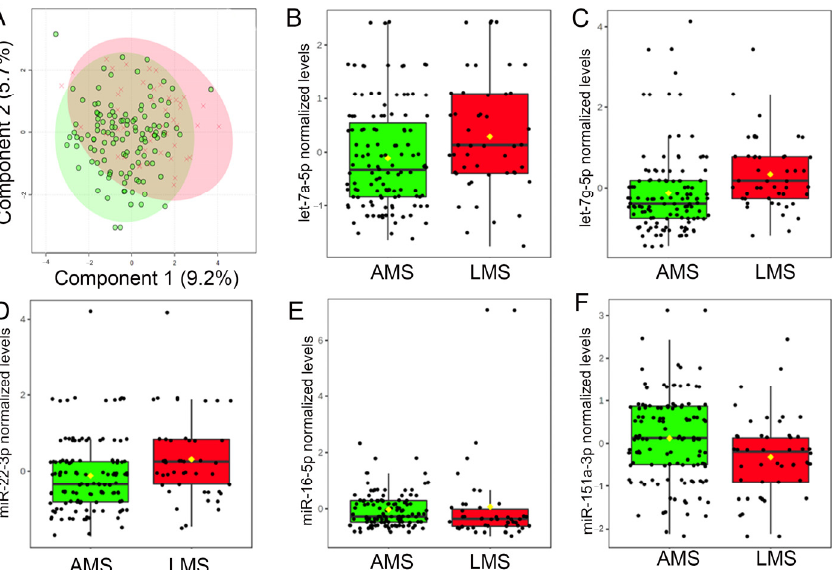
Figure 2. Levels of miRNAs in breast milk differ among women with low milk supply. ( A ) Results of a two-dimensional partial least squares discriminant analysis (PLSDA) employing levels of 30 miRNAs with the most robust concentrations in maternal breast milk in the first week after delivery. Note that total milk miRNA profiles do not differ between mothers with adequate milk supply (AMS; green) and mothers with low milk supply (LMS; red). However, milk levels of five miRNAs did differ in the milk of mothers with LMS. In the first week after delivery, levels of ( B ) let-7a-5p (V = 2194, p = 0.015, adj p = 0.090), ( C ) let-7g-5p (V = 1765, p = 8.5 × 10 − 5 , adj p = 0.0025), and ( D ) miR-22-3p (V = 2135, p = 0.0080, adj p = 0.080) were higher in the milk of mothers with LMS, whereas levels of ( E ) miR-16-5p (V = 0.3595, p = 0.013 adj p = 0.090) and ( F ) miR-151a-3p (V = 3670, p = 0.0063, adj p = 0.080) were lower.